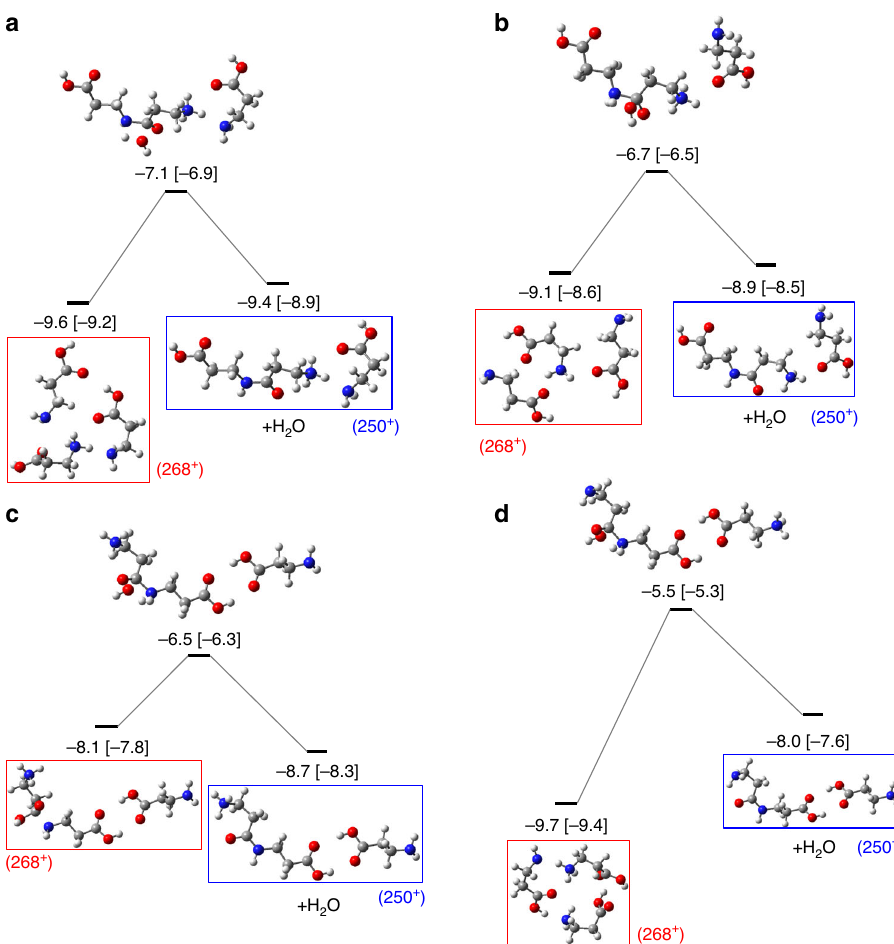
Fig. 5 Potential energy surface exploration of the singly charged protonated trimer. Determining steps of dipeptide formation starting from different initial N -protonated trimer systems ( m / z = 268), shown in red boxes, and leading to a N -protonated dipeptide with a β -alanine molecule attached ( m / z = 250), shown in blue boxes, with water release. Panels ( a – d ) represent four possible pathways starting with different con fi gurations of the protonated trimer. Relative energies (in eV) computed at the CCSD/6-311 ++ G(d,p) level over the geometry optimized with the AM1 method and referred to the most stable neutral trimer are given next to the molecular structures. In square brackets: relative energy computed with DFT-M062X/6-311 ++ G(d,p). H atoms are given in white, C atoms in gray, N atoms in blue, and O atoms in